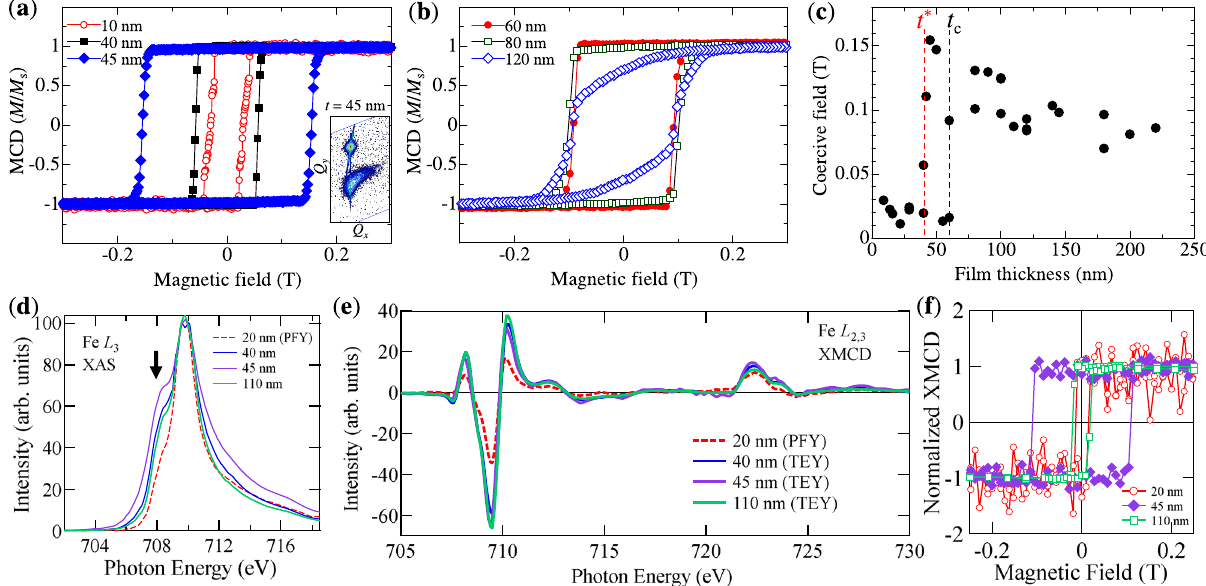
Fig. 4 Magnetic properties of SmIG fi lms measured by MCD and XMCD. a , b Magnetic hysteresis loops of MCD with the fi eld applied perpendicular to the fi lm surface for ( a ) 10-, 40-, and 45 nm-thick and ( b ) 60-, 80-, and 120-nm-thick fi lms. Partial relaxation is observed for the 45 nm-thick fi lm as shown by RSM in the inset of ( a ). c Thickness dependence of coercive fi eld H c . t c (~60 nm) and t * (~40 nm) represent the critical thickness estimated from the bulk lattice constant and the thickness where relaxation starts as estimated from structural analysis. d Fe L 3 -XAS spectra. The intensities are normalized to the peak heights. The black arrow denotes the shoulder structure. e Fe L 2,3 -XMCD spectra. The XAS and XMCD spectra were obtained in TEY mode, except for the 20 nm-thick fi lm, which was obtained in PFY mode. f Magnetic- fi eld dependence of the XMCD intensity for 20-, 45-, and 110 nm-thick fi lms at room